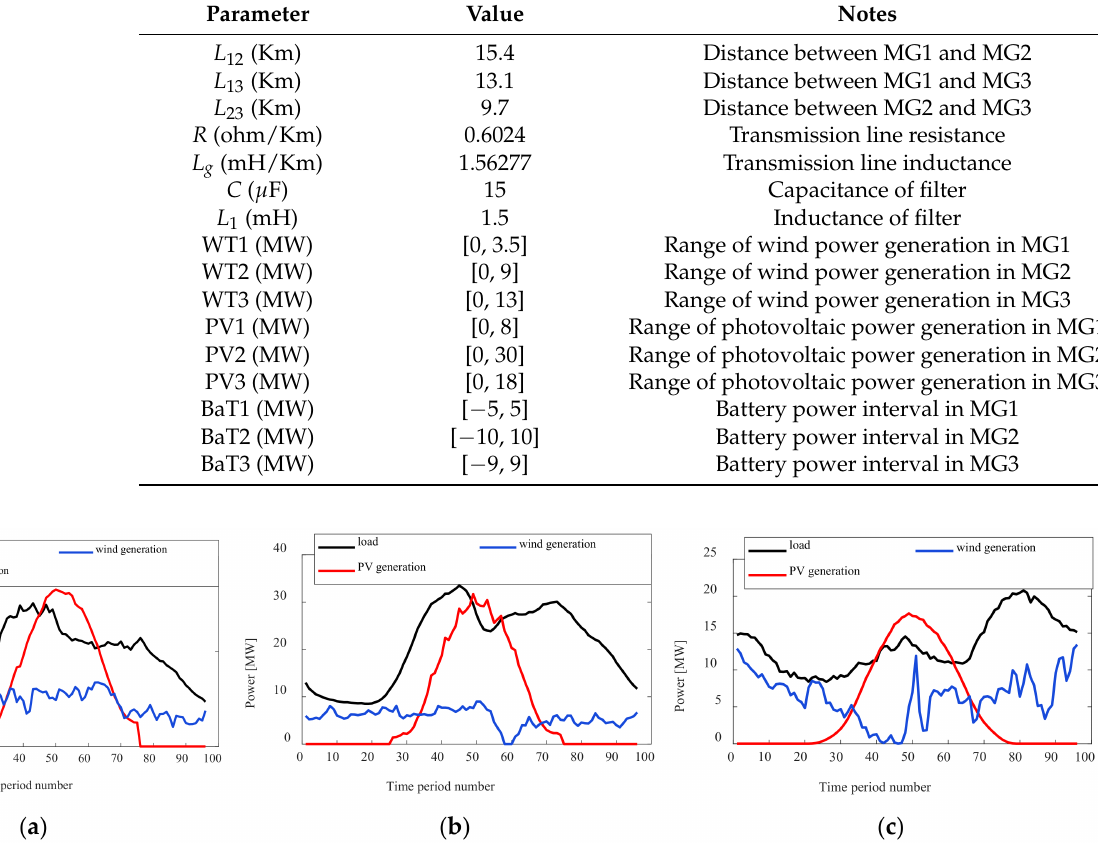
Figure 4. Microgrid of different areas: ( a ) schools; ( b ) villages; ( c )